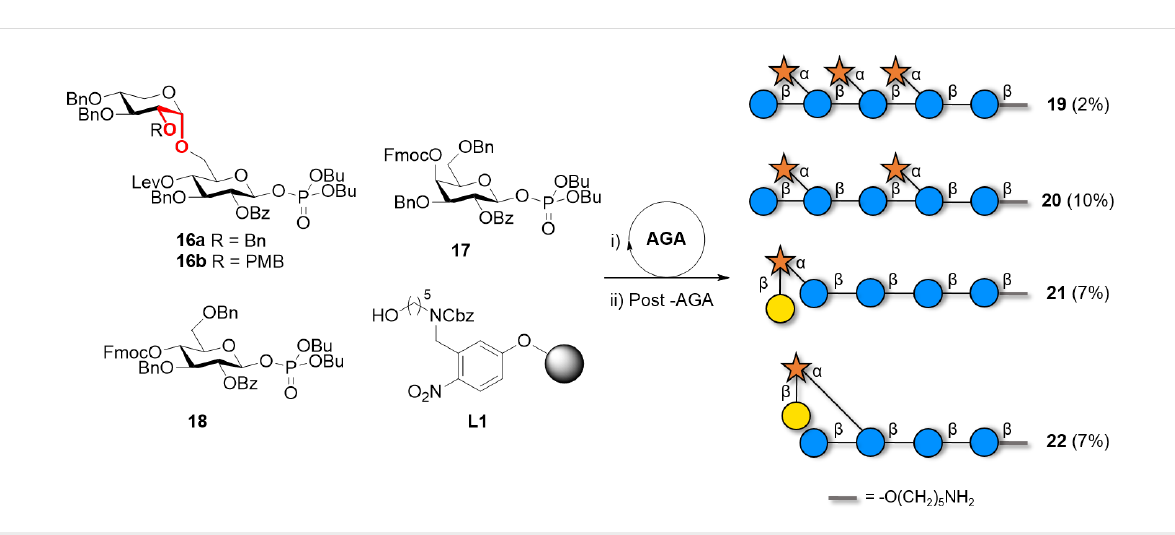
Scheme 3: AGA of XG analogues with defined side chains. The AGA cycle includes coupling (TMSOTf), Fmoc deprotection (Et 3 N), PMB deprotec- tion (DDQ) and Lev deprotection